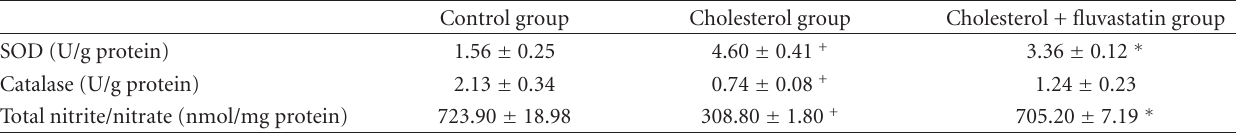
Table 2: Antioxidant enzyme activities and total nitrite/nitrate levels in carotid artery tissues from all